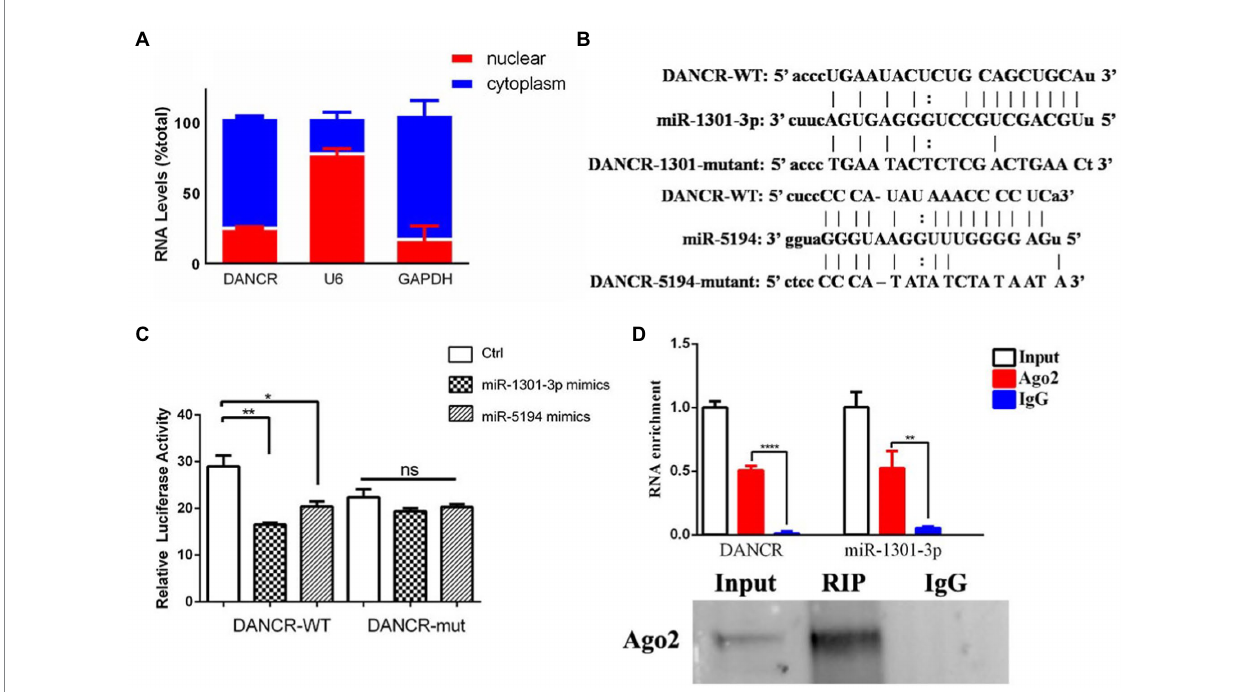
FIGURE 2 DANCR physically interacted with miR-1301-3p. (A) The cytoplasmic and nuclear RNA of PMA-stimulated THP-1 cells were isolated, and the amount of DANCR in different components was measured via qRT-PCR. U6 and glyceraldehyde 3 phosphate dehydrogenase (GAPDH) was used as reference genes in the nucleus and the cytoplasm, respectively. (B) The sequence of microRNA recognition element (MRE) regions within wild-type DANCR was acquired through Starbase, and the binding sites of miR-1301-3p/miR-5194 were mutant artificially. (C) Human embryonic kidney (HEK293) cells were co-transfected with mimics of miR-1301-3p/miR-5194 and the pmiR-GLO vector containing wild-type DANCR plasmid (DANCR-WT) or mutant DANCR plasmid (DANCR-mut). The cells were harvested for measuring luciferase activity after 48 h. (D) The PMA-stimulated THP-1 cells were lysed and precipitated by magnetic beads coupled with Argonaute 2 (Ago2) antibodies, and the precipitates were subsequently detected by using qRT-PCR (upper panel) and Western blotting (bottom panel). Normal IgG was used as a negative control. Data represent the mean ± standard deviation (SD) from three replications. * p < 0.05, ** p < 0.01, and **** p <